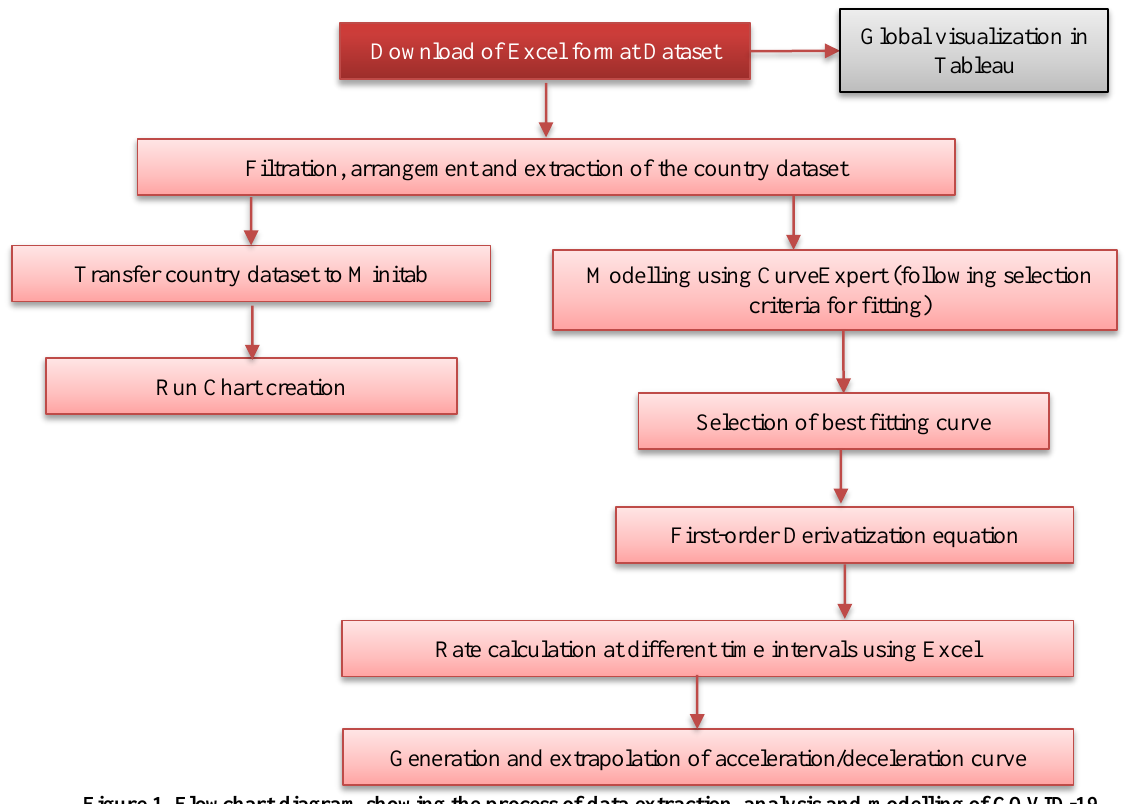
Figure 1. Flowchart diagram showing the process of data extraction, analysis and modelling of COVID-19 morbidity and